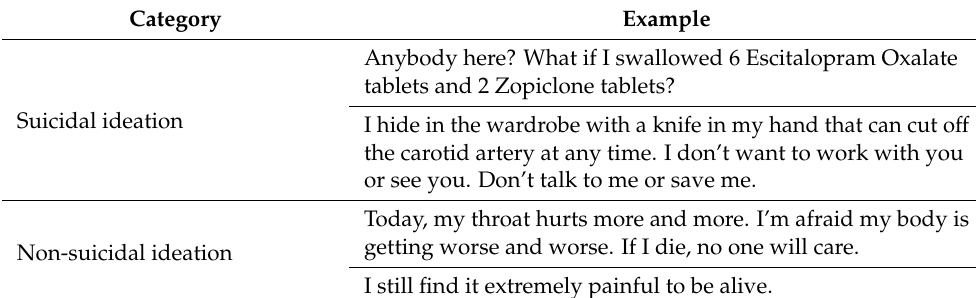
Table 2. Examples of suicidal ideation and non-suicidal ideation